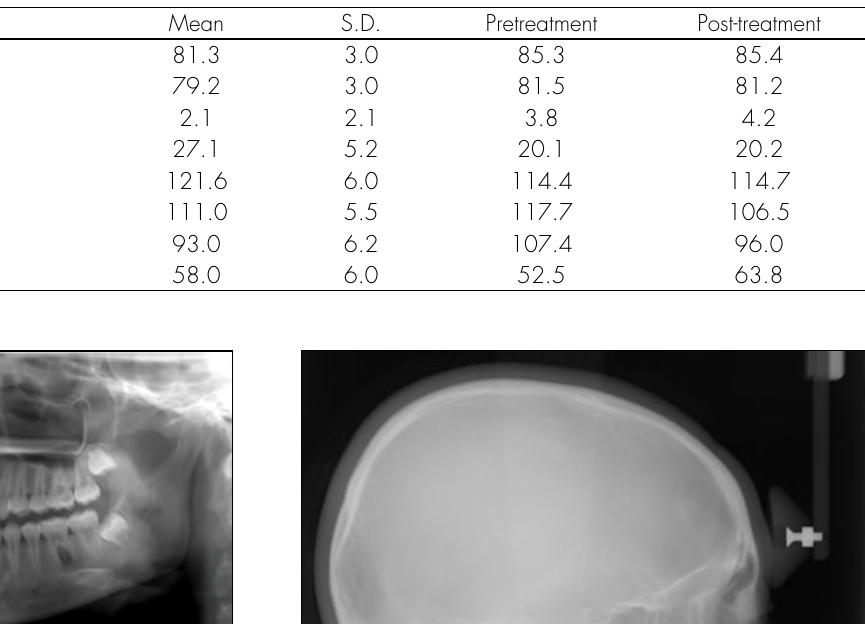
Table I. Cephalometric